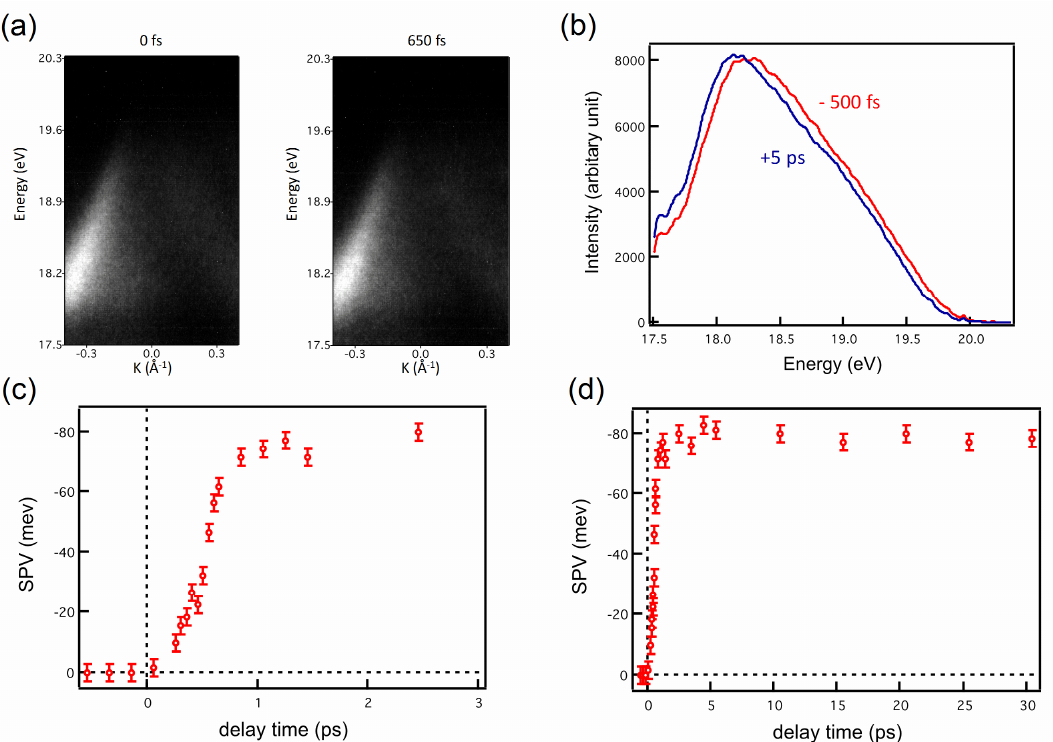
Figure 13. TR-ARPES measurements of the ultrafast surface photovoltaic (SPV) effect in p-GaAs (100). ( a ) TR ARPES spectra of the valence band near the Г point at 0 fs and 650 fs delay after the excitation pulse. Vertical axis: photoelectron (PE) energy (eV); Horizontal axis: PE momenta k (Å −1 ); ( b ) typical energy distribution curves (EDC) of valence band measured before the excitation pulse (−500 fs) and after the excitation pulse (+5 ps); ( c ) temporal evolution of SPV effect with 650 fs rise-time. Delay steps are 67 fs; ( d ) SPV effect over showing a plateau lasting >30 ps.